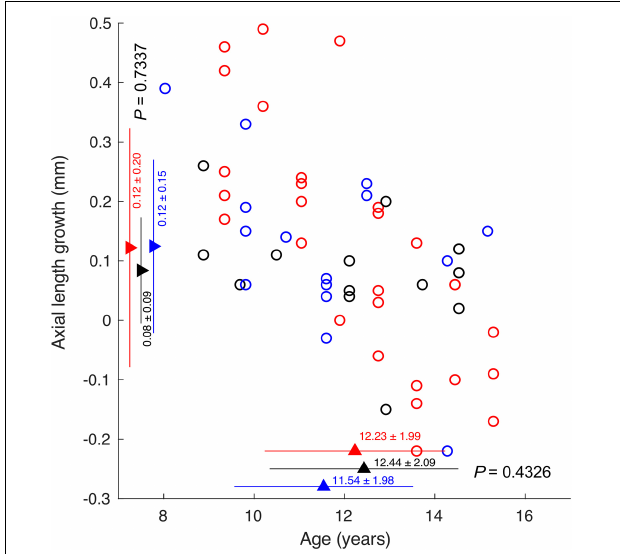
FIGURE 7 | The correlation between axial length growth and age. Circles indicating subjects whose ODT peaked at day 1 (red), 1 week (black), and 2 weeks or later